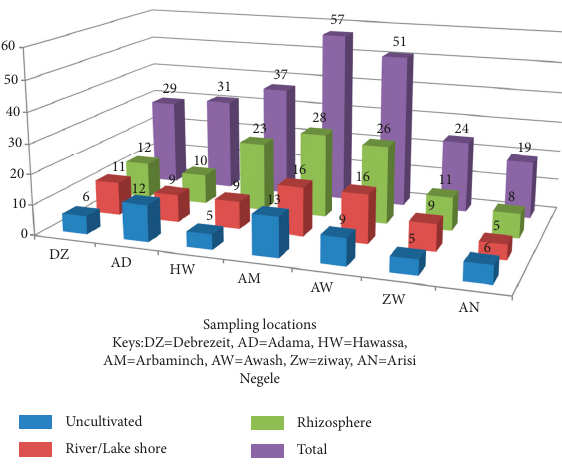
Figure 1: Number of actinomycete isolates from the Rift Valley areas of Ethiopia. Table 1: Proportion of antimicrobial activity of actinomycete